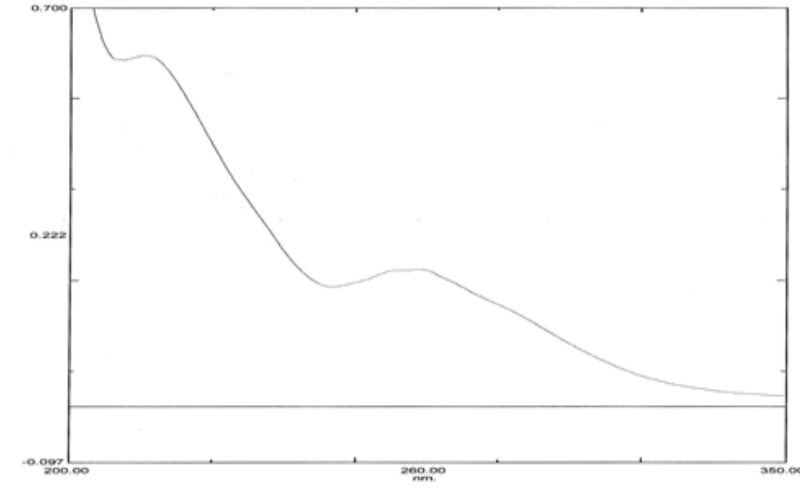
Figure 2. Absorption spectrum of Bosentan (10 µg ml -1